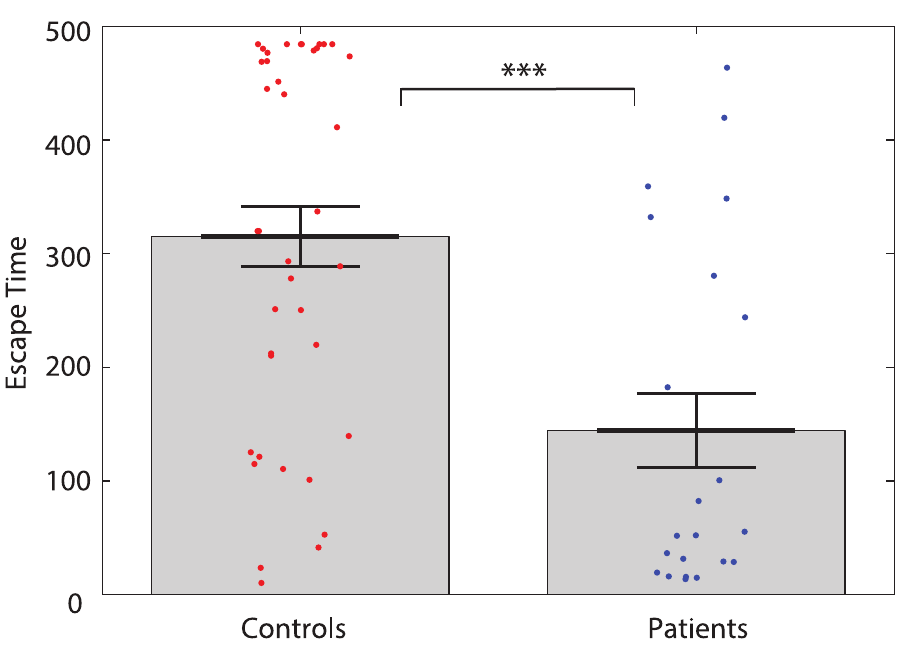
Fig 1. Patient ’ s nodes tend to escape to the seizure state faster than control ’ s. Comparison of patients and controls initial transition times into the seizure state. A seizure state was deemed to have occurred once three nodes had escaped, so the times here are when the third node hit the seizure state. Asterisks represent a significant difference found at p < 0.001 using a Mann-Whitney U test. Each dot represents the mean escape time for one individual subject over 100 iterations, grey bars reach the mean of each subject group, error bars show the standard error of the mean. Higher times indicate that the individual took longer to reach a seizure